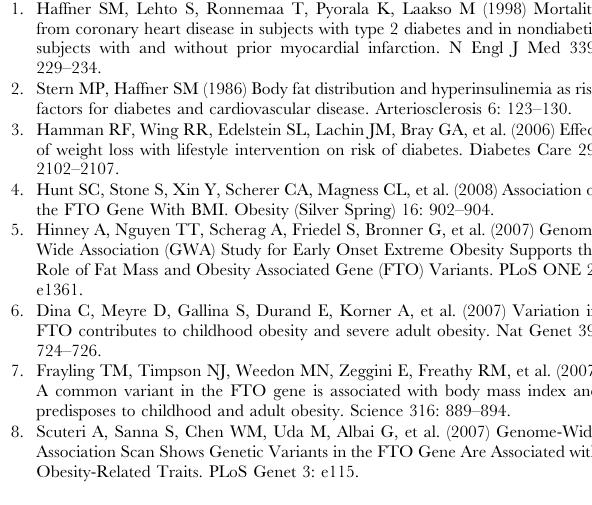
Table S2 Linkage disequilibrium (LD) between FTO SNPs in HapMap populations.